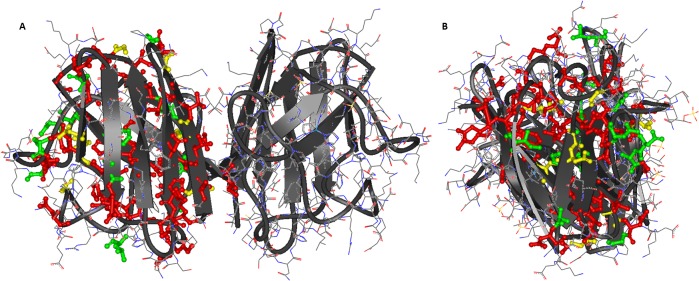
64 Sites in human SOD1 subject to 77 missense variants for which patient age of ALS onset t(o) has been reported, out of 150 variants studied in this work.
A) seen from the dimer longside perspective. B) seen from the end perspective. Sites are marked in ball-and-stick on the protein structure (2C9V.pdb[26]) according to t(o) < 55 (red), t(o) > 55 (green), or sites with variants showing phenotypes with both t(o) > 55 and t(o) < 55. See Table I in S1 File for details. Figure made with ViewerLite 4.2, Accelrys.